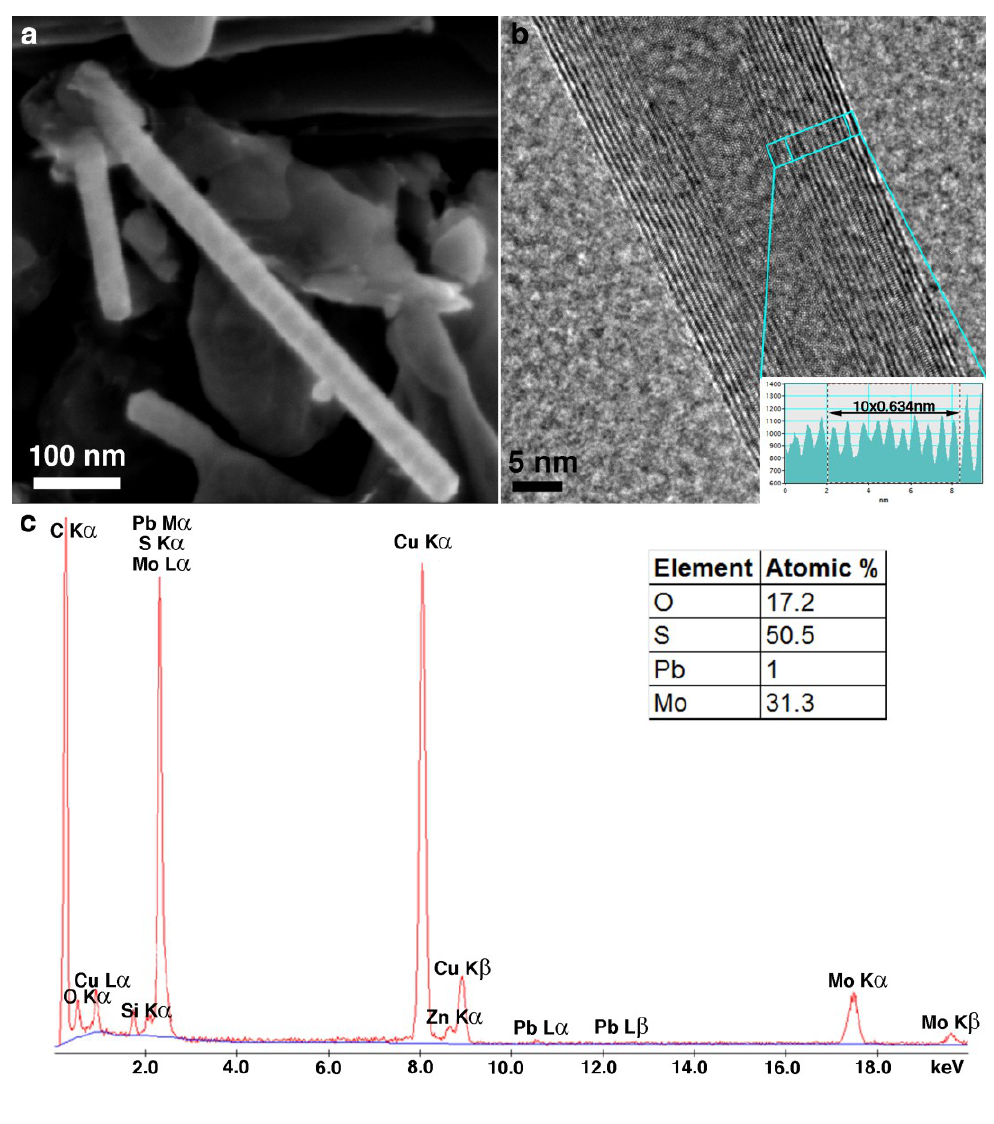
2 nanotube (adapted after [15]). 2 (0.62 nm); ( c ) EDS spectrum 2